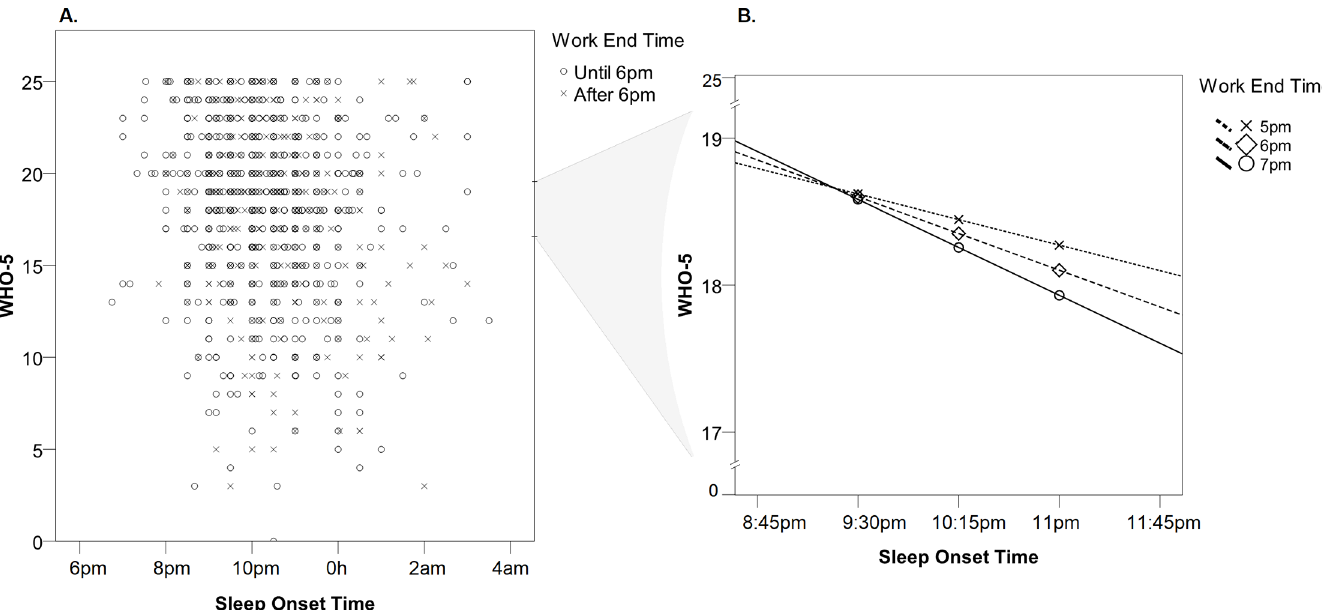
Fig 2. Interrelationship between WHO-5, sleep onset time, and work end time. A. Scatterplot graph with the total distribution of WHO-5 scores according to sleep onset time for categorical work end time—until and after 6pm (cutoff: median value); B. Conditional effect of sleep onset time on psychological well-being at the P25, P50 and P75 values of work end time.